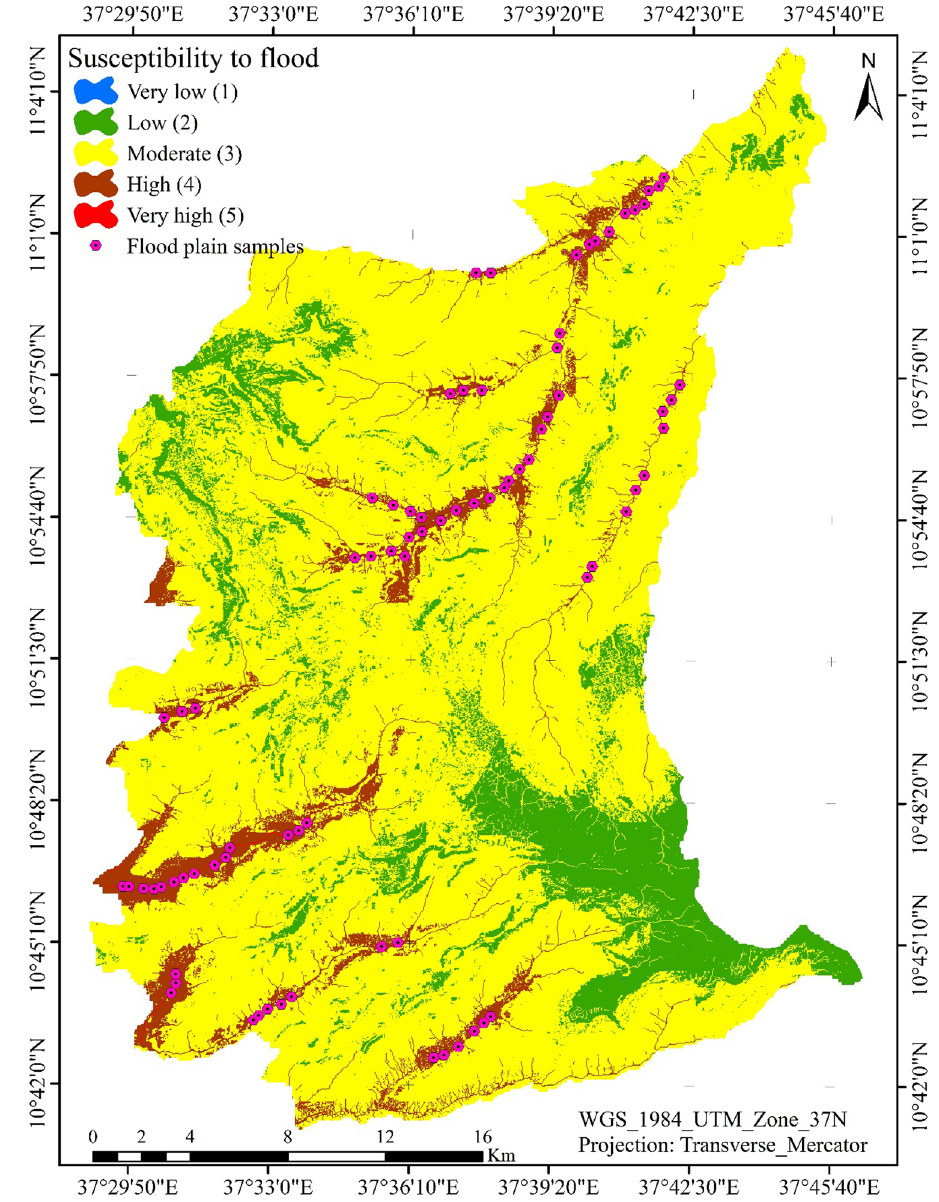
Fig. 7 Flood susceptibility map of the study area